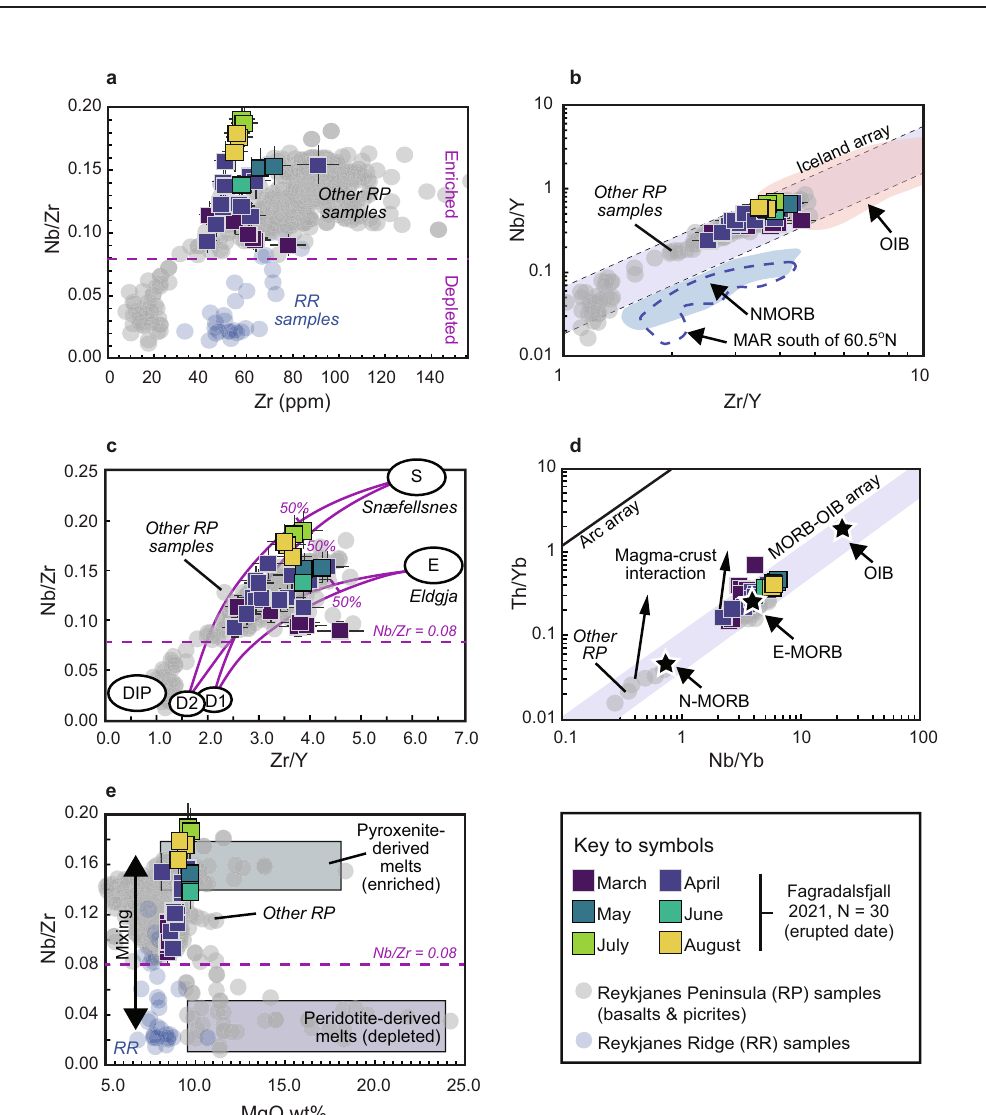
Fig. 3 Temporal changes in geochemistry of Fagradalsfjall whole-rocks. a TAS diagram after ref. 49 with comparative literature data for Reykjanes Peninsula (RP) basalts. Fagradalsfjall whole-rock lava samples are tholeiitic basalts. b – f Timeline plots of MgO ( b ), K 2 O/TiO 2 ( c ), Nb/Zr ( d ), Zr/Y ( e ), and Th/Yb ( f ). In b , the mean MgO wt.% for RP basalts is shown as a black horizontal line and the height of the grey box corresponds ±1 SD; for all other plots the full range of literature data is shown. In panel d , enriched samples are de fi ned as having a Nb/Zr ratio >0.08 (after ref. 28 ). In panel f , mantle end- members are indicated after ref. 50 . Note that there are relatively few Th/Yb ratios available for RP basalts in the literature. The dashed vertical lines in all panels indicate the timing of additional vent openings; the second vent (#2) and the last new vent (#6) as labelled in panel b . Abbreviations: EMORB enriched mid-ocean ridge basalt, NMORB normal mid-ocean ridge basalt, OIB ocean island basalt, RP Reykjanes Peninsula. Uncertainty on major and trace element data is estimated at better than 5% and 10%, respectively (shown as error bars). Where no error bars are visible, uncertainty is smaller than symbol size. Literature data are taken from refs. 25,28,51 – 56 .